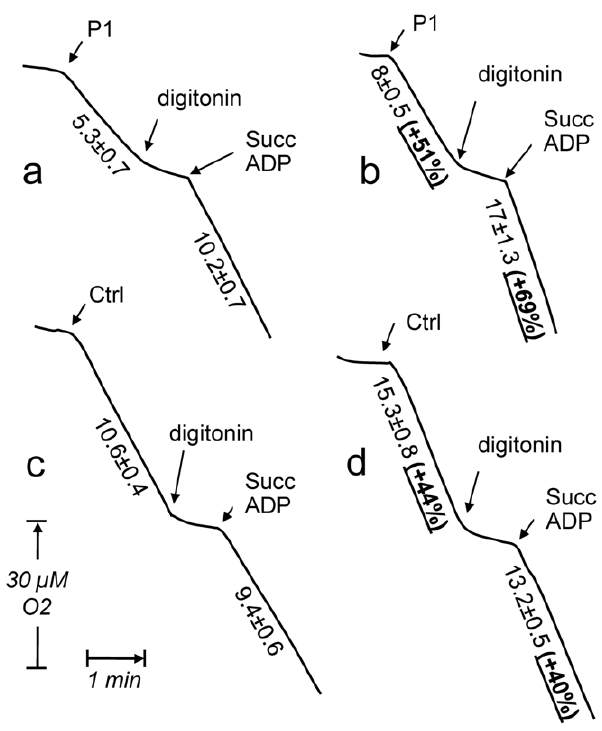
Figure 2. Respiration and mitochondrial substrate oxidations in patient 1 (P1) and control cells grown in the absence or presence of palmitate. Intact P1 cell respiration was 51% higher in cells grown in the presence of palmitate (comparison traces a and b). A subsequent addition of 0.004% digitonin made cells (approximately 2.10 6 cells) permeable to small molecules including respiratory substrates, with the subsequent dilution of respiratory substrates and progressive arrest of oxygen consumption. Adding 10 mM succinate (Succ) and 0.4 mM ADP triggered a rapid oxygen uptake which was 70% higher for P1 cells grown with palmitate (b). A similar effect, albeit less pronounced of growing cells in the presence of palmitate could be observed using control cells (comparison traces c and d). Numbers along the traces are nmol/min/mg protein. Values are means 6 SEM from triplicate experiments. Experimental procedures as described under Materials and methods.